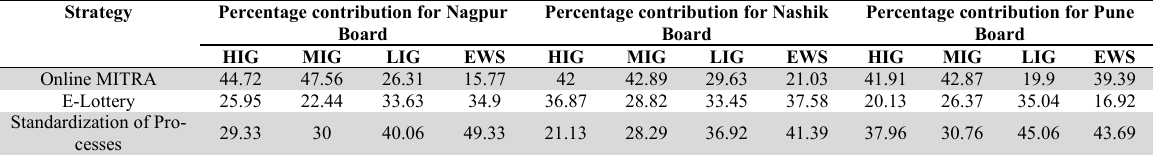
Percentage contribution of every strategy (Nagpur, Nashik and Pune Board)